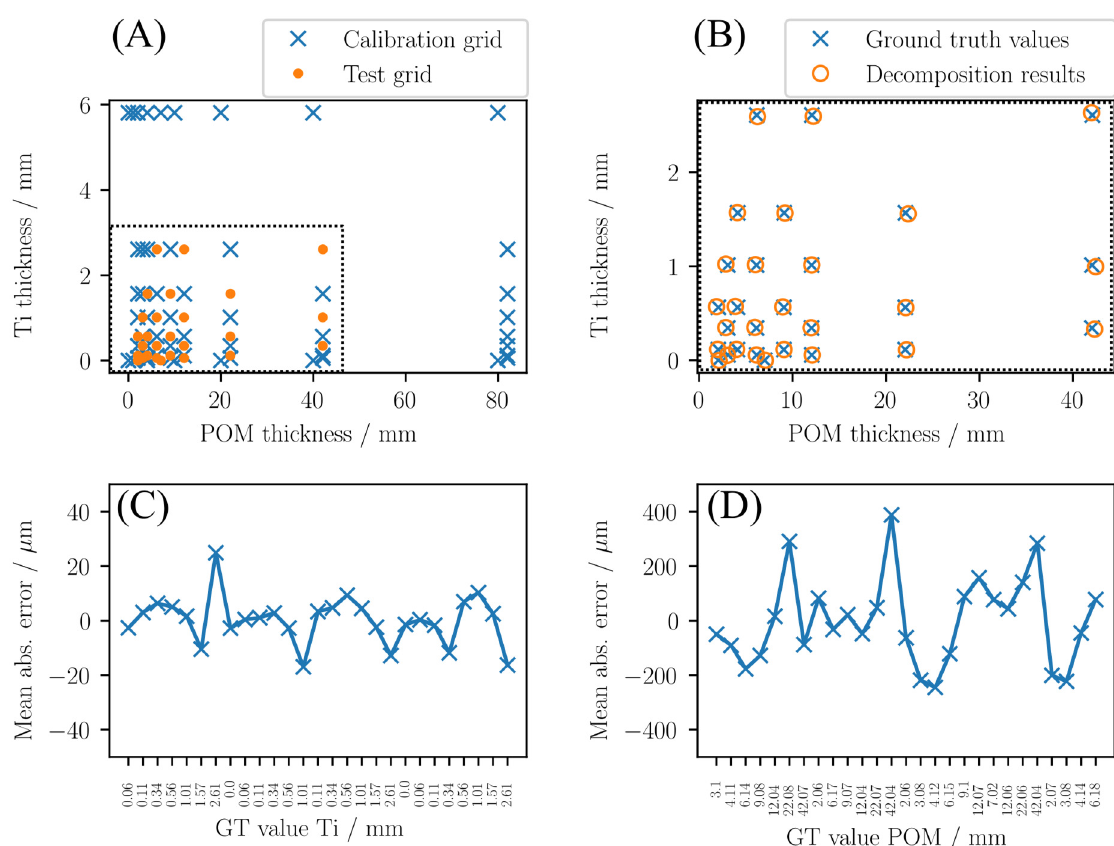
Fig 2. Decomposition accuracy. In order to asses the reliability of the calibration of the forward-model in Eq 4 a testgrid different from the calibration grid was acquired (A). The measured dual-energy data was decomposed into basis material thicknesses (B) and compared to the ground truth (GT) values for Ti (C) and POM (D),